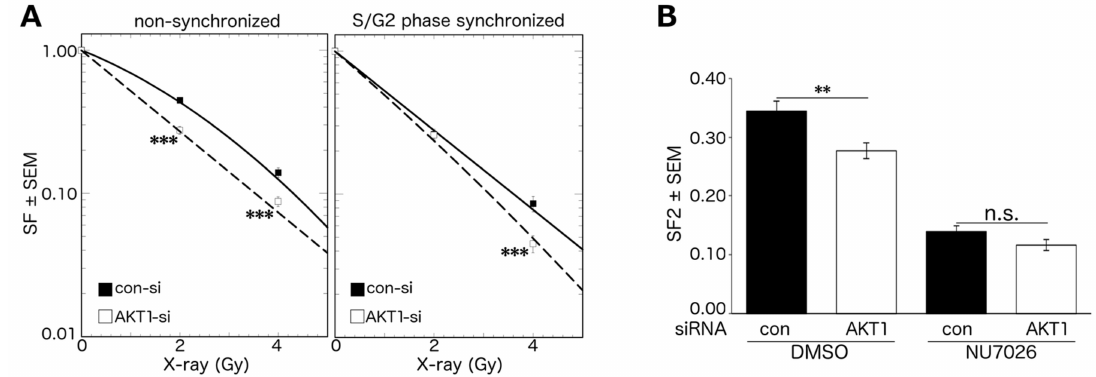
Figure 4. Akt1 increases post-irradiation clonogenic survival via NHEJ repair. A549 cells were treated with AKT1-siRNA or con-siRNA. ( A ) Cells were synchronized in S/G2 phase or kept